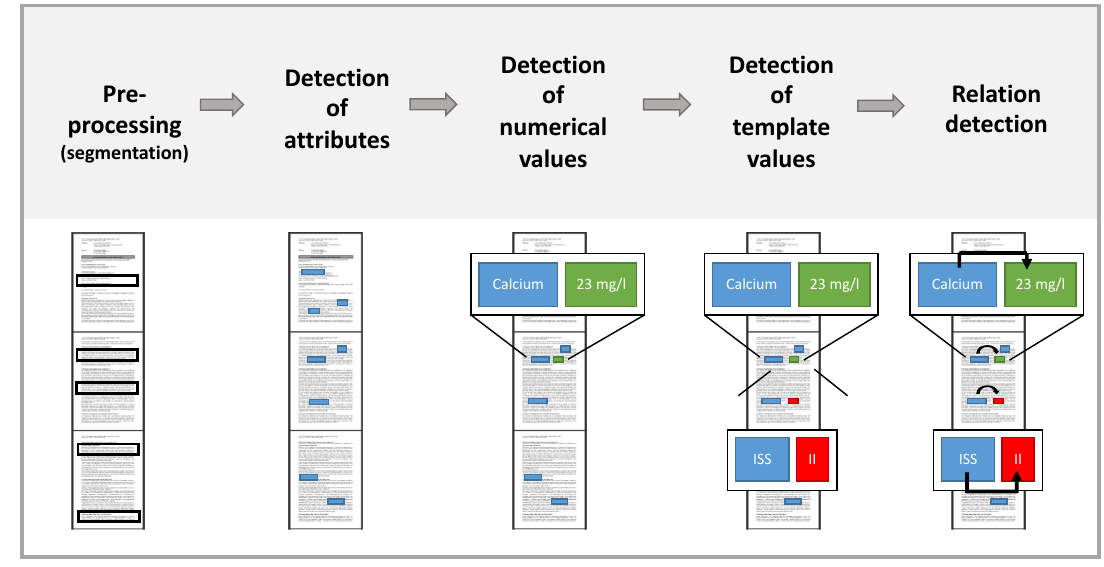
Figure 1. Architecture of the ARIES algorithm. After pre-processing ARIES detects attributes, numerical values and template values. Next, ARIES relates the detected